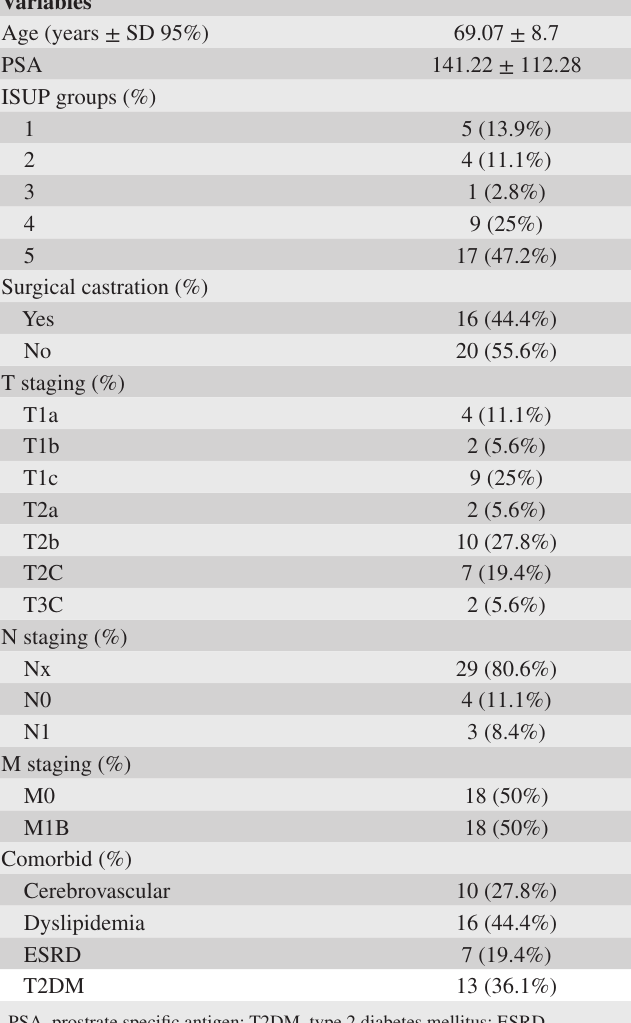
Table 1. Demographic Characteristics